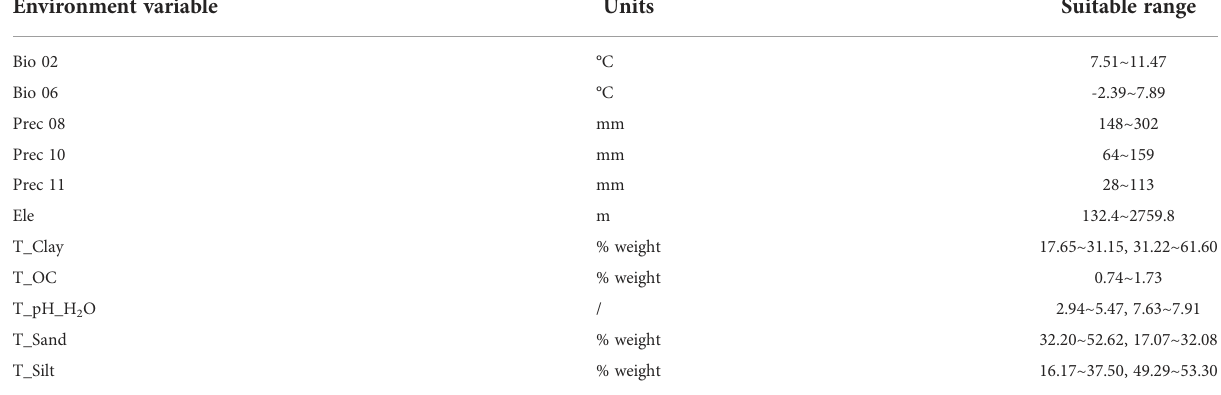
TABLE 1 The suitable range for main